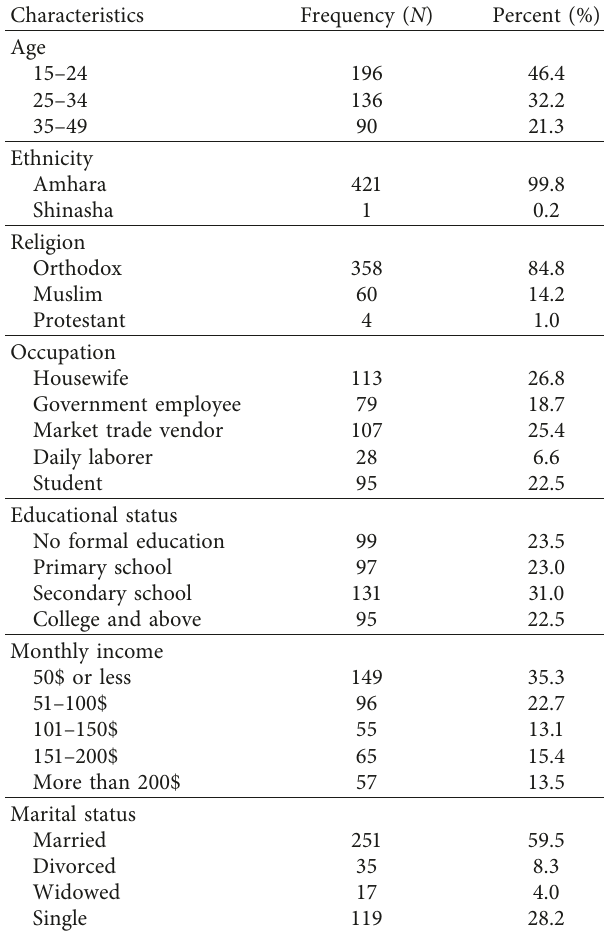
Table 1: Sociodemographic characteristics of women in Adet, Gojjam, Northwestern Ethiopia, 2016 ( n �